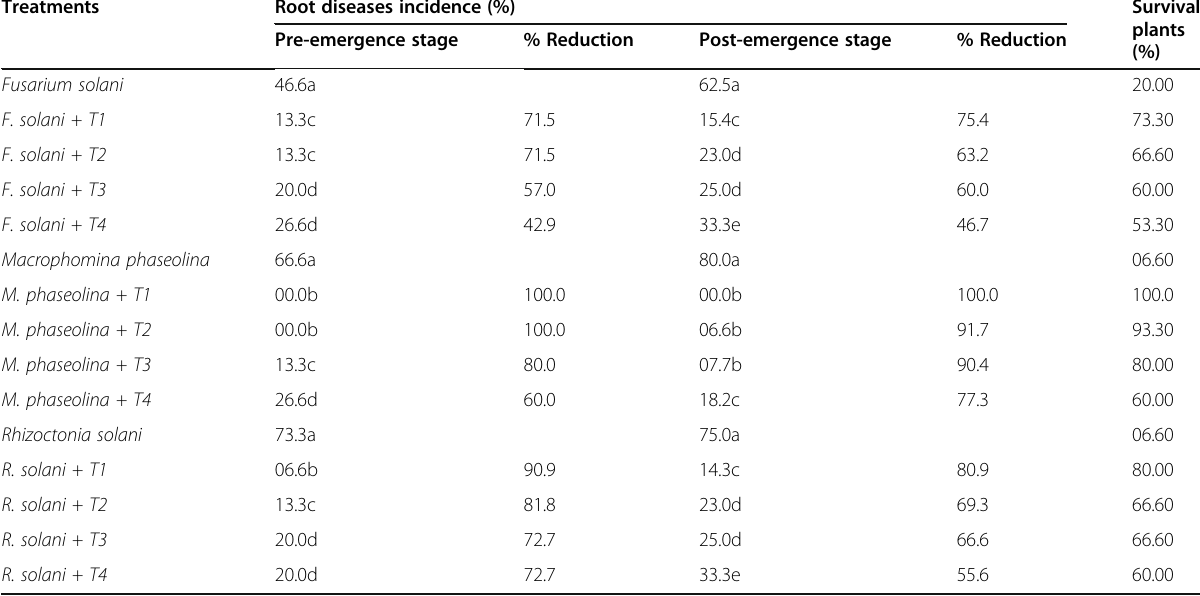
Table 5 Effect of applying seed treatment against faba bean root diseases caused by soil-borne fungi under greenhouse conditions Treatments Root diseases incidence (%)